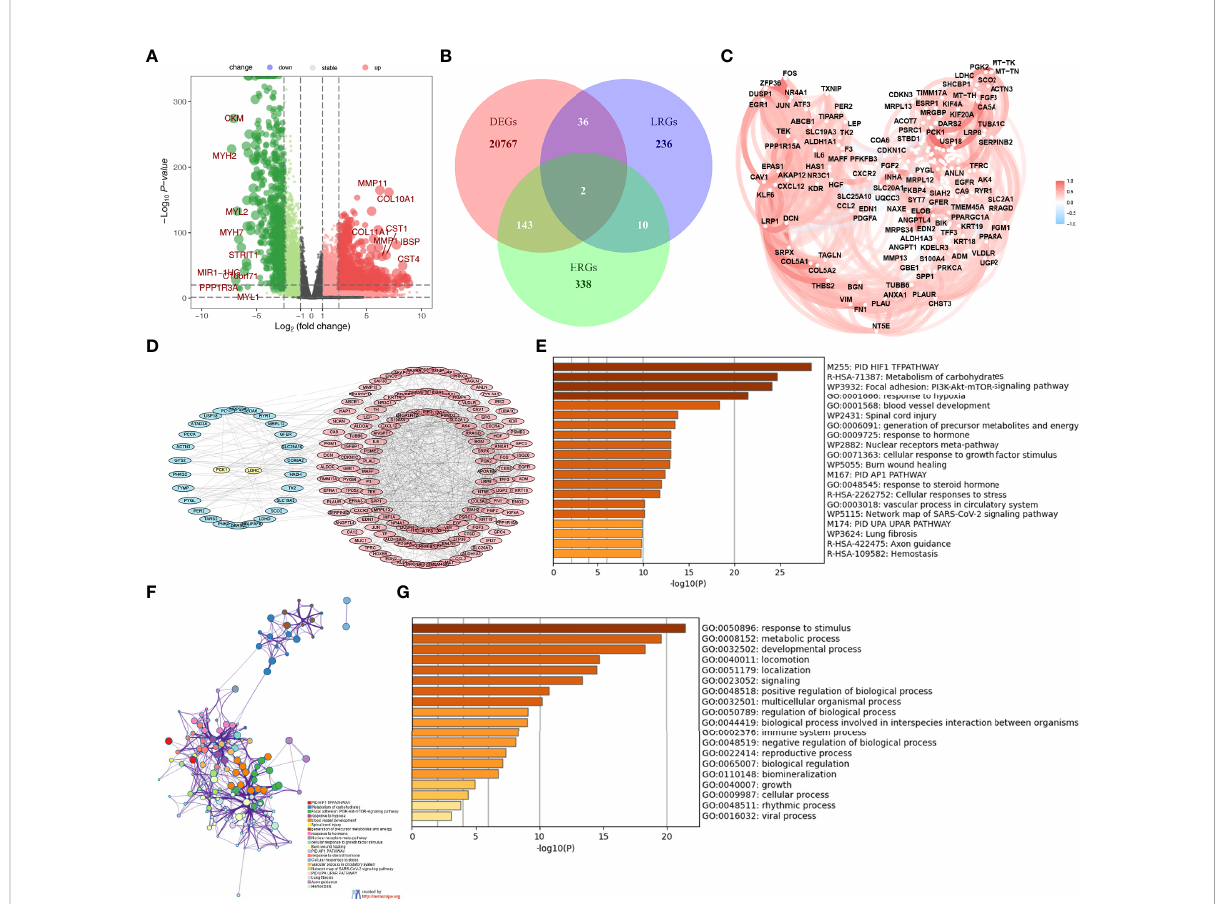
FIGURE 1 Identi fi cation of the differential expressed HRGs and LMRGs. (A) The volcano plot of the DEGs. (B) The Veen diagram of the DEGs, HRGs, and LMRGs. (C) The relationship of the DEHRGs and DELMRGs in breast cancer. (D) The PPI network of the DEHRGs and DELMRGs in the string database. (E – G) The function of the DEHRGs and DELMRGs in the Metascape